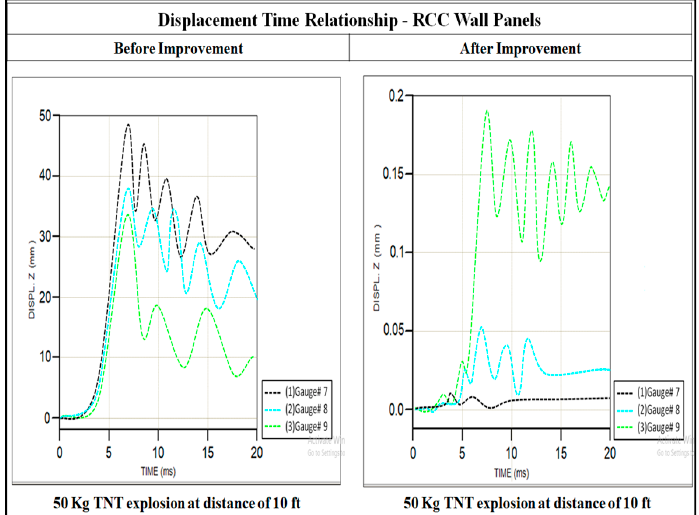
Figure 8. Comparison of TNT explosions at the face of RCC wall panels.